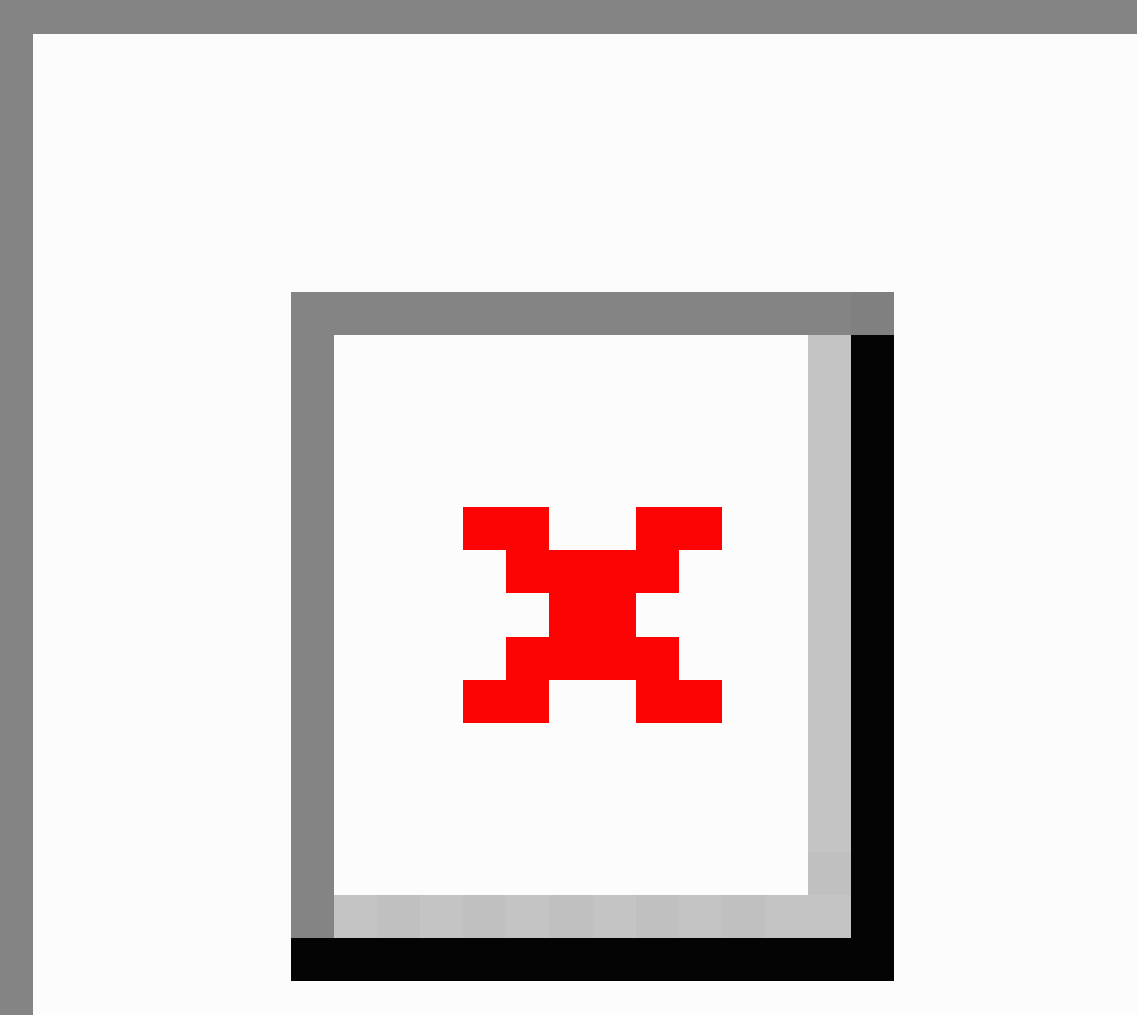
Figure 1. Organization of features into the complete feature set C (left) and the incomplete feature set S (right). The checkmark symbol indicates that a value for a feature is present in a client record, whereas the cross symbol indicates a value is missing